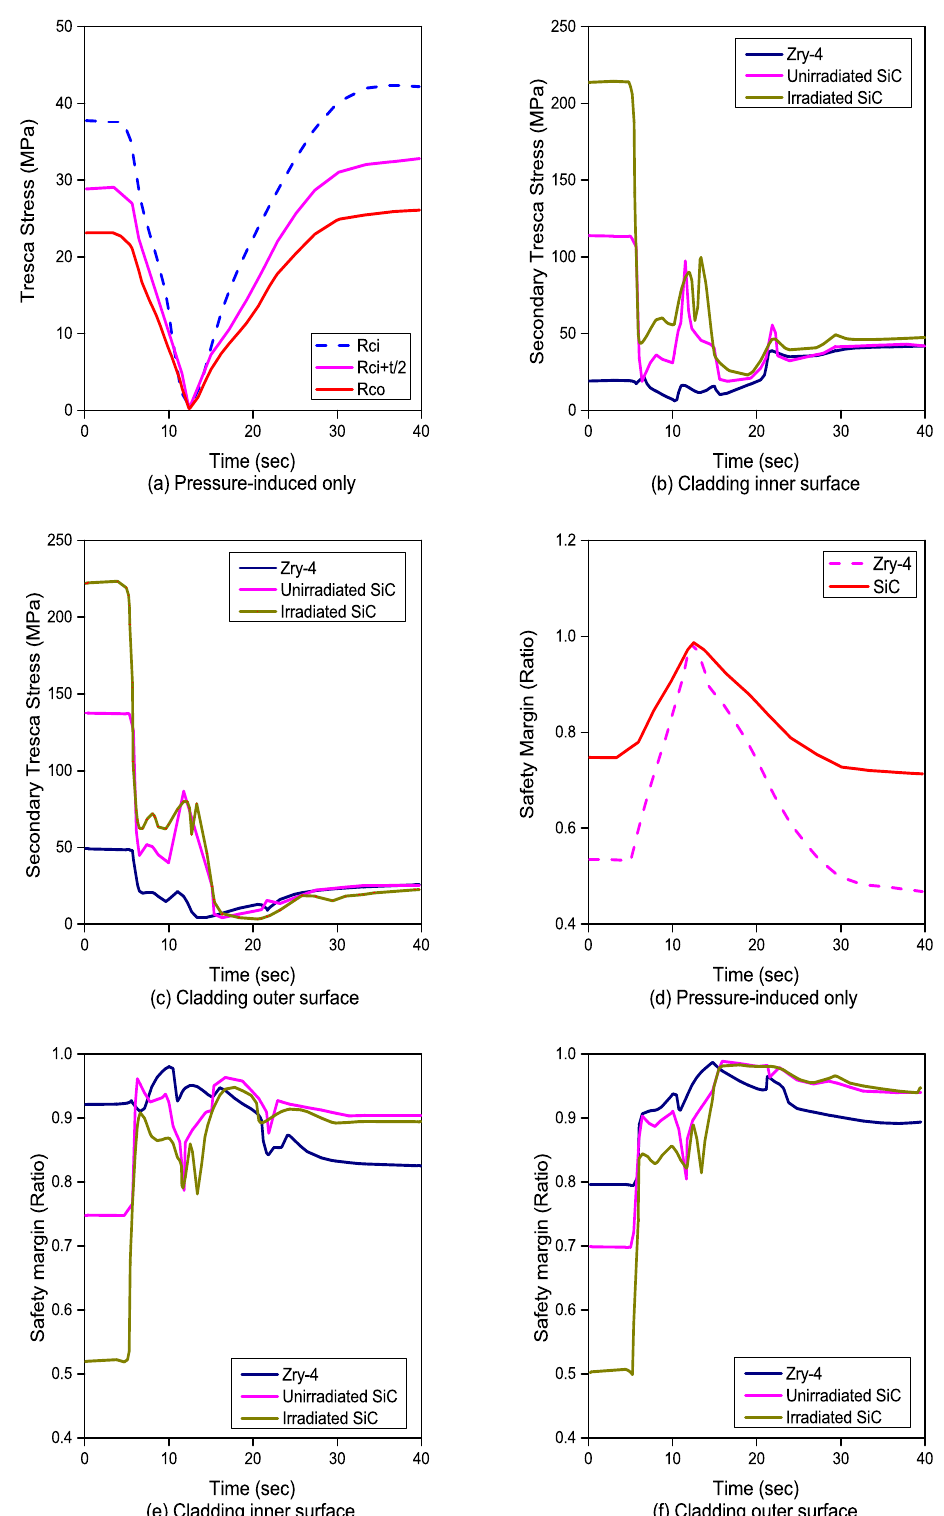
Figure 9. Tresca stress and safety